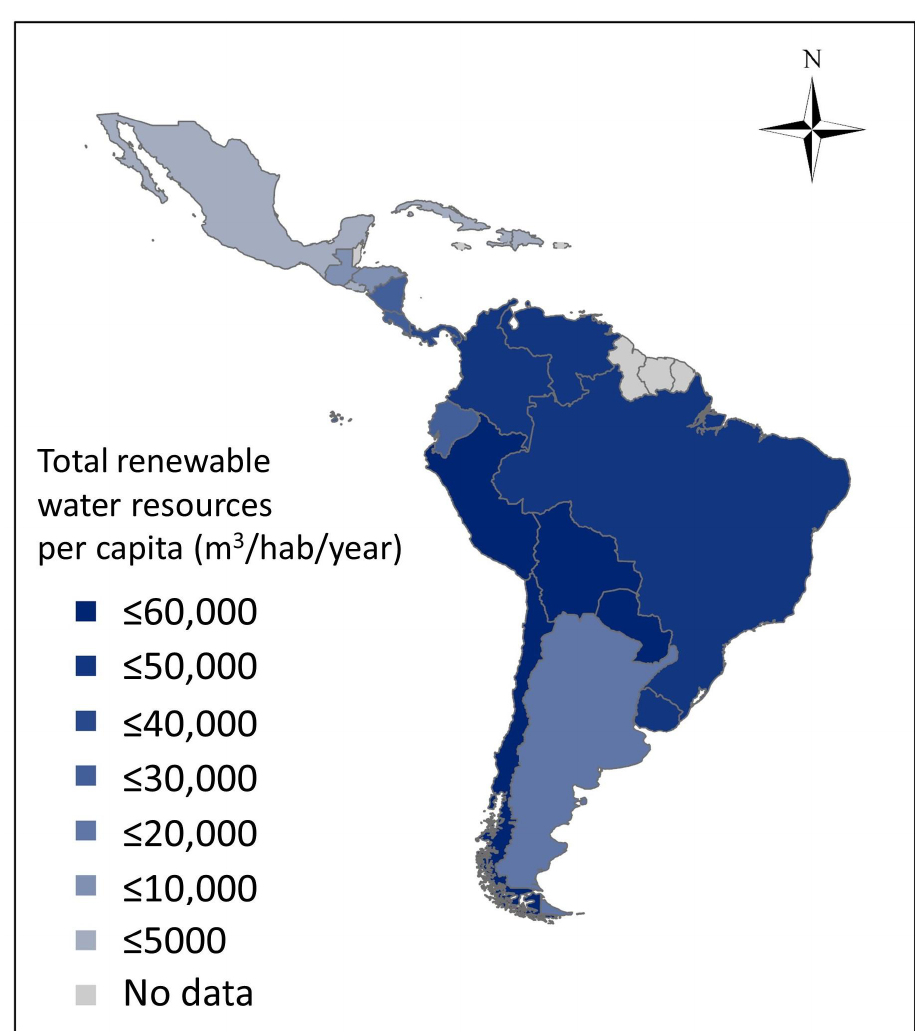
Figure 2. Total annual renewable water resources per capita by country in Latin America and the Caribbean. Source: FAO (2017) [7].